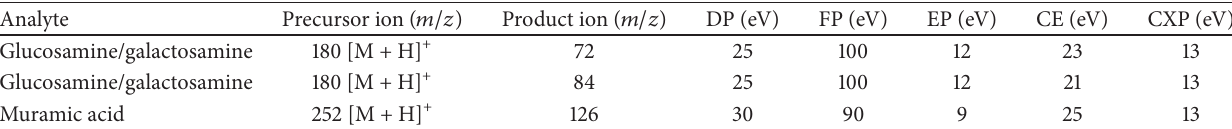
GlcN and GalN concentrations calculated using (3) and (4) with slope coefficients ( 𝑘 ) derived from coefficients of slope from calibration curves determined from standard solutions analyzed within the same acquisition batch. Table 2: Analyte-specific mass spectrometer parameters applied in the reported method: DP: declustering potential, FP: focusing potential, EP: entrance potential, CE: collision energy, and CXP: cell exit potential.